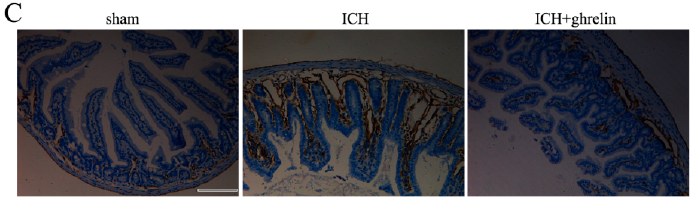
Figure 4. Ghrelin downregulated intestinal intercellular adhesion molecule-1 (ICAM-1) expression after ICH. ( A ) ICAM-1 mRNA was increased following ICH induction compared with the sham group, while ghrelin administration downregulated ICAM-1 expression at the mRNA level post-ICH. n = 6; ( B ) ICAM-1 protein levels were higher in the ICH mice than in the sham mice; however, ghrelin significantly inhibited ICH-induced ICAM-1protein levels. n = 6; ( C ) Representative photomicrographs of immunostaining for ICAM-1 in each group. ICAM-1 was more clearly observed in the ICH group than that in sham group; however, the ICAM-1-positive cells were significantly reduced in the ghrelin-treated group post-ICH. n = 4; Scale bar = 100 µ m. The values are the mean ± SD, # p < 0.01 vs. sham group; * p < 0.05 vs. ICH group; The data are representative of six ( A , B ) or four ( C ) independent experiments performed in triplicate.